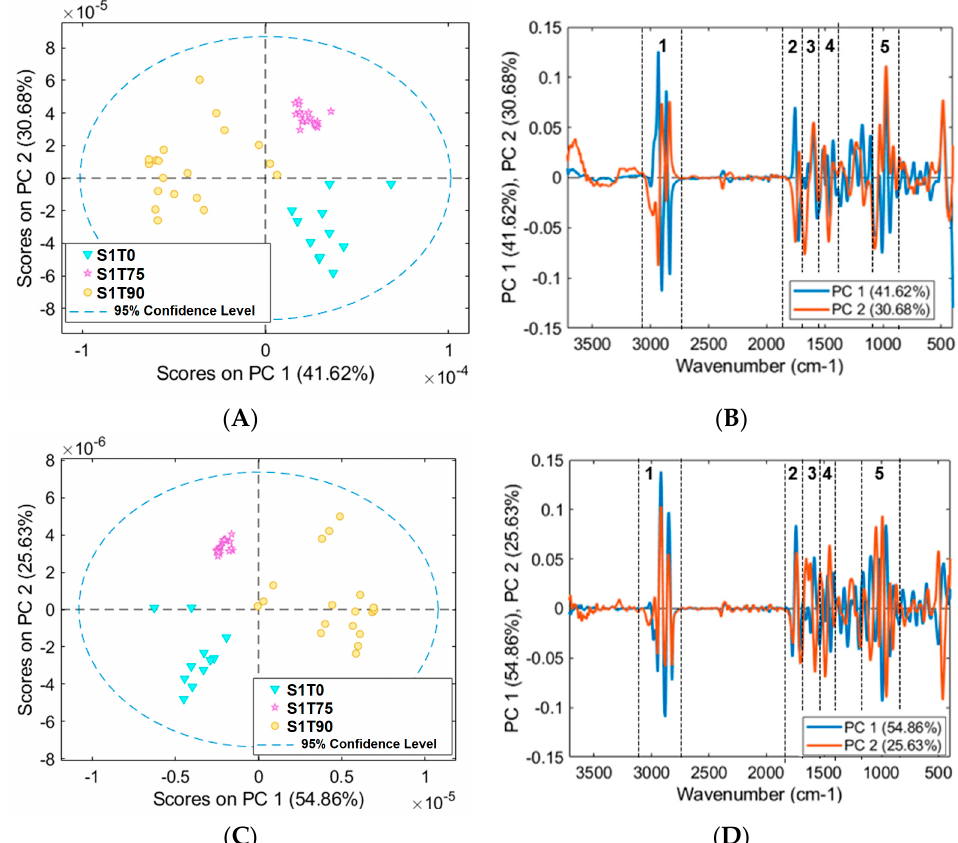
Figure 4. Score ( A ) and loading ( B ) plots from fi rst derivative spectra and score ( C ) and loading ( D ) plots from second derivative spectra of S1 samples, respectively. The numbers indicated in ( B ) and ( D ) correspond to the following spectral ranges: (1) 2950 – 2820 cm − 1 (C-H stretching); (2) 1770 – 1740 cm − 1 (COOH stretching / carbonyl (C=O) stretching); (3) 1680 – 1650 cm − 1 (N-H stretching and C=O stretching of amide I); (4) 1510 – 1450 cm − 1 (C=C-C aromatic ring stretching/C-C aromatic stretching (conjugated with C=O), asymmetric C-H bending from lipids, protein, lignin; (5) 1100 – 960 cm − 1 (carbonyl (C=O) stretching (fa tt y acid) / C-O and C-C (pectin) / C-O-C symmetric stretching/C-O, C=C and C-C-O stretching of cellulose and hemicellulose).